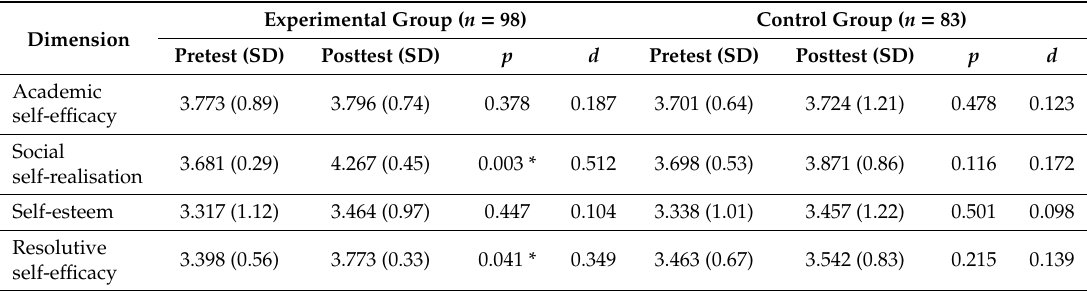
Table 3. Pretest–posttest group comparisons and e ff ect